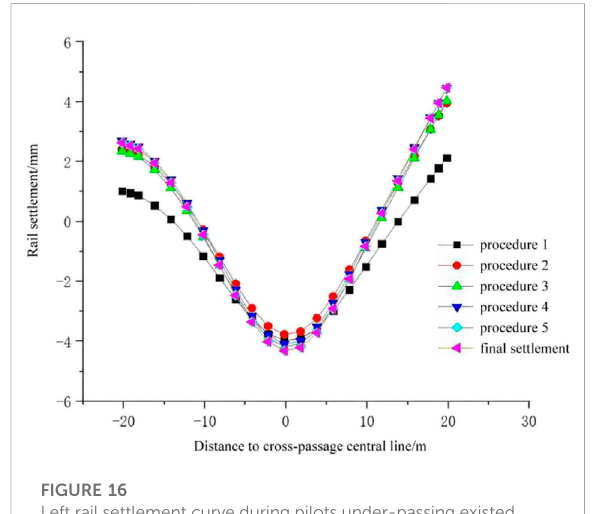
FIGURE 16 Left rail settlement curve during pilots under-passing existed railway line.